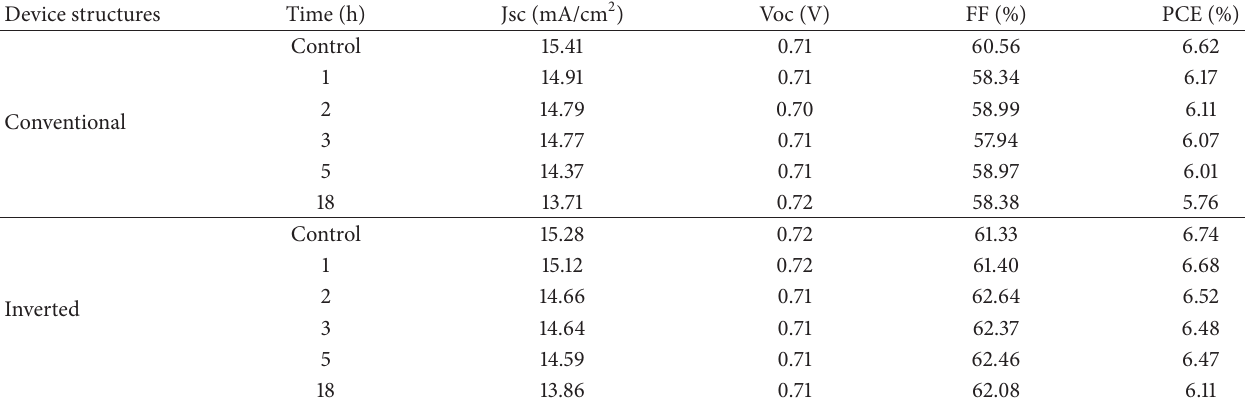
Table 1: Device parameters of the conventional and inverted devices which are kept at 70 ∘ C for different time. Device